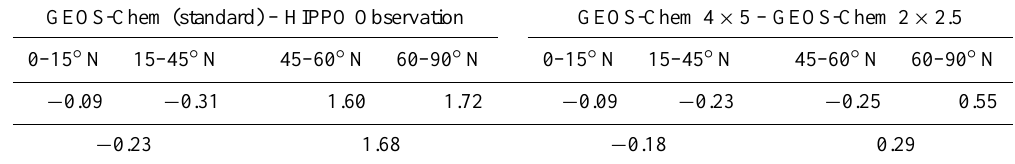
Table 1. Mean differences in CO 2 (ppm) between GEOS-Chem and HIPPO and between the GEOS-Chem 4 ◦ × 5 ◦ and 2 ◦ × 2.5 ◦ simula-